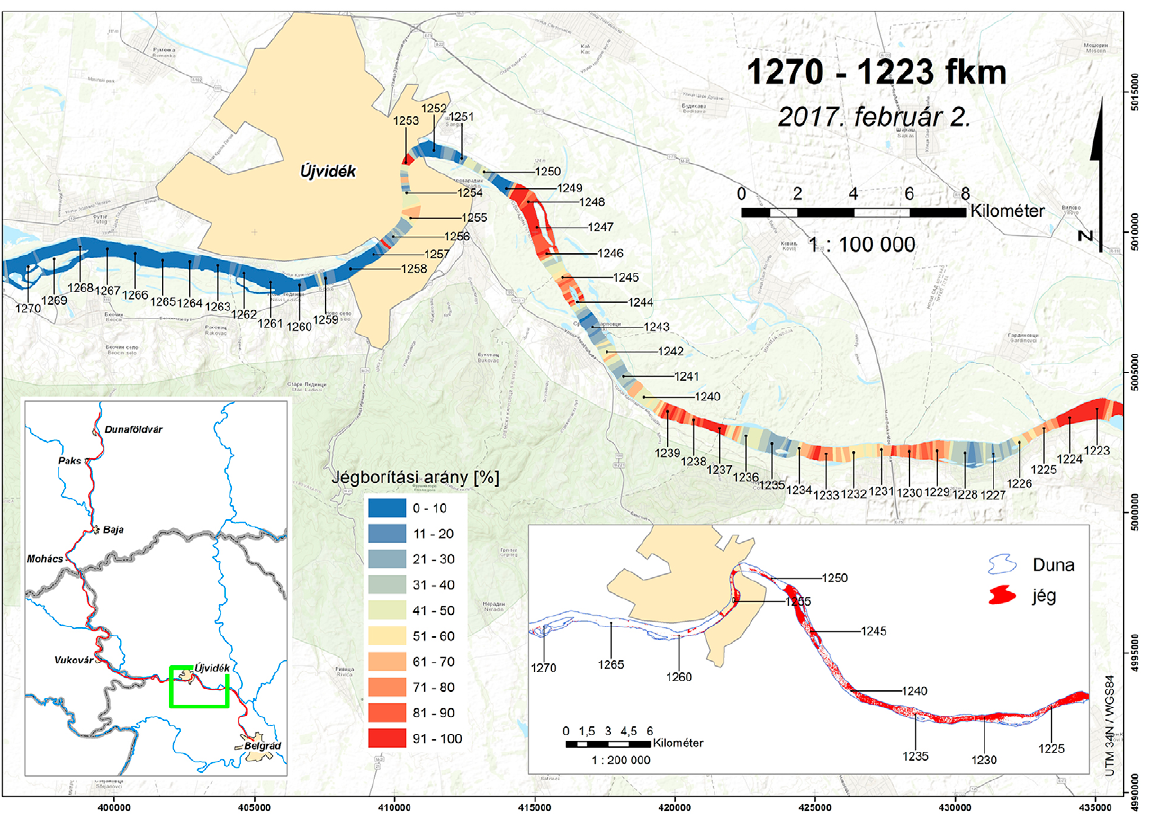
Figure 7. Sample layout of a selected Danube section (1270-1223 river km) on February 2,